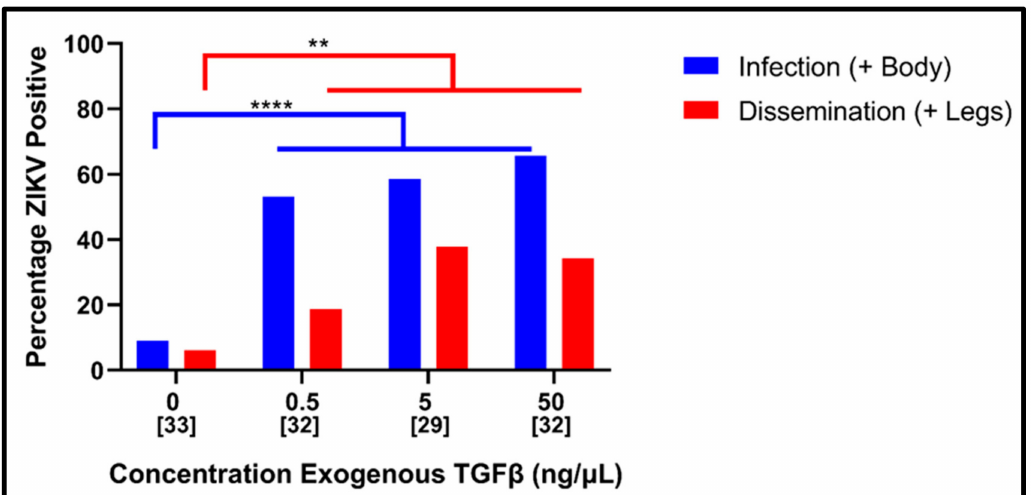
Figure 1. Effect of TGF- β 1 on susceptibility of Ae. aegypti to ZIKV. Strain PRVABC59 at a titer of 4.2 log 10 FFU/mL was provided to female mosquitoes (Galveston F5) in artificial bloodmeals that were supplemented with exogenous human TGF- β 1 at indicated doses. Blood-fed mosquitoes were incubated at 27 ± 1 ◦ C with 80 ± 10% relative humidity and a 16:8 light:dark cycle for fourteen days, at which point they were collected and analyzed for the presence or absence of ZIKV by Vero cell assays. Data are presented as percentages: 100 * [number of infected bodies (infection) or legs (disseminated infections) over total number of mosquitoes assayed in a given condition]. Numbers in brackets indicate sample sizes. * p < 0.05, ** p < 0.01, *** p < 0.001 and **** p <